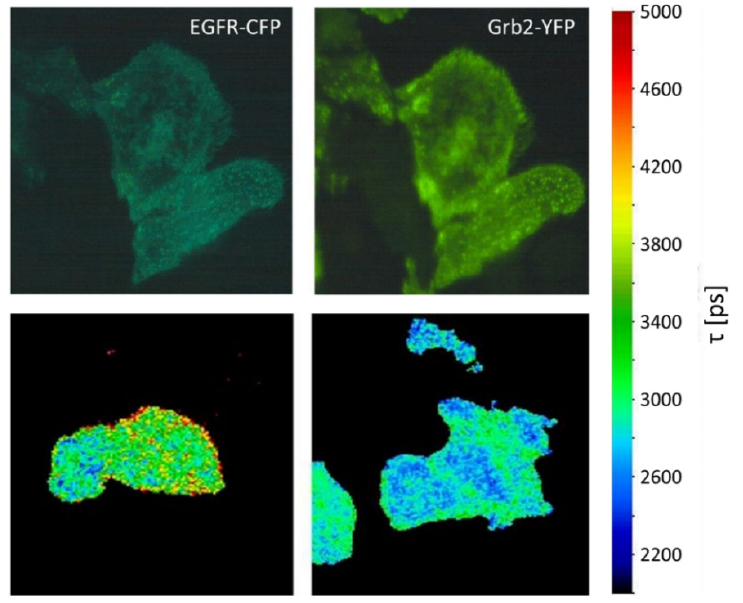
Figure 6. TIR fluorescence images of HeLa cells transfected with EGFR-CFP and Grb2-YFP in the spectral ranges of donor (450–490 nm) and acceptor ( λ ≥ 510 nm) emission (top); fluorescence lifetimes of the donor EGFR-CFP in absence (bottom, left) and presence (bottom, right) of the acceptor; excitation wavelength: 420–440 nm; image size: 60 µ m × 60 µ m (top), 100 µ m × 100 µ m (bottom). Reproduced from [39] with